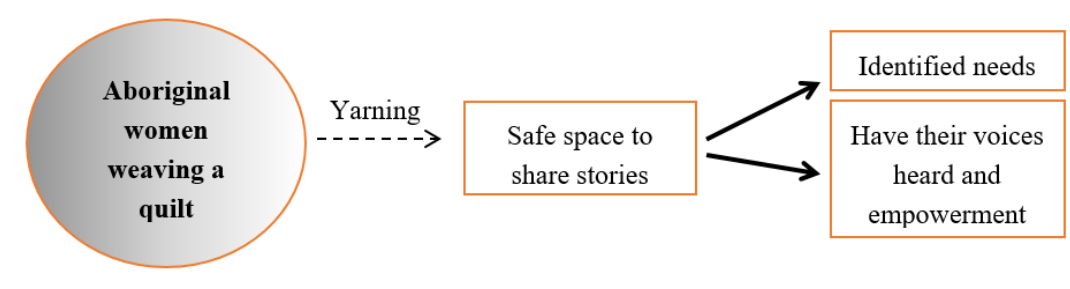
Figure 1. Process of data generation and observed outcomes.